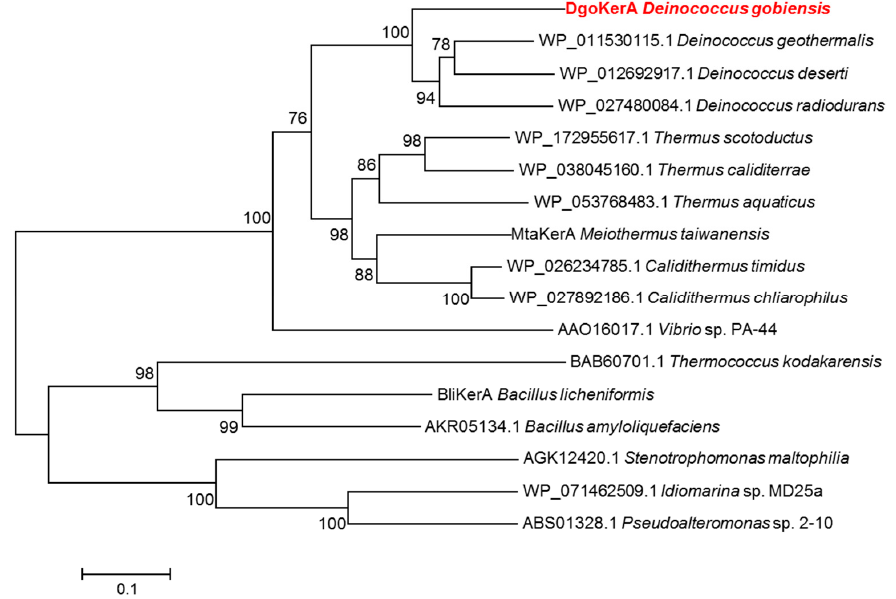
Figure 1. Phylogenetic analysis of amino acid sequence of keratinases. The name and GenBank accession No. for each protease are in front of the Latin name of each strain. The phylogenetic tree was constructed by MEGA 6.0 with neighbor-joining (NJ) method. The percentages of replicate trees in which the associated taxa clustered together in the bootstrap test (1000 replicates) are shown next to the branches.